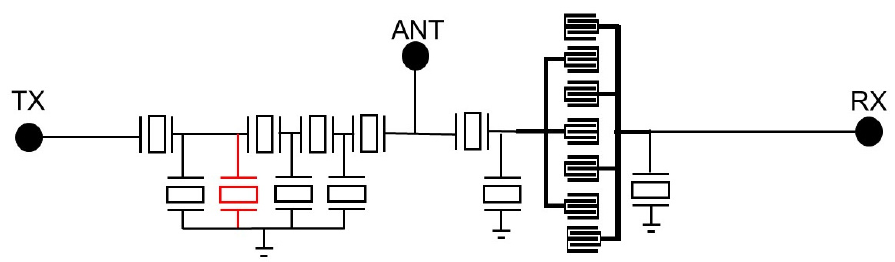
Figure 1. The structure of band 5. The red indicates the suppression resonator. TX—transmitter port; RX—receiver port; ANT— antenna port.